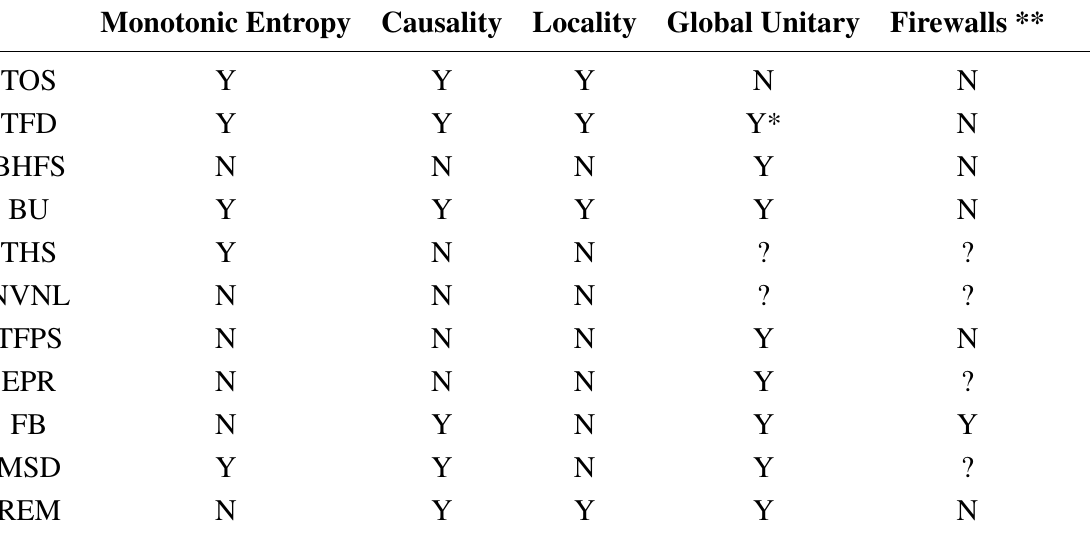
Table 1. A non-exhaustive table of popular